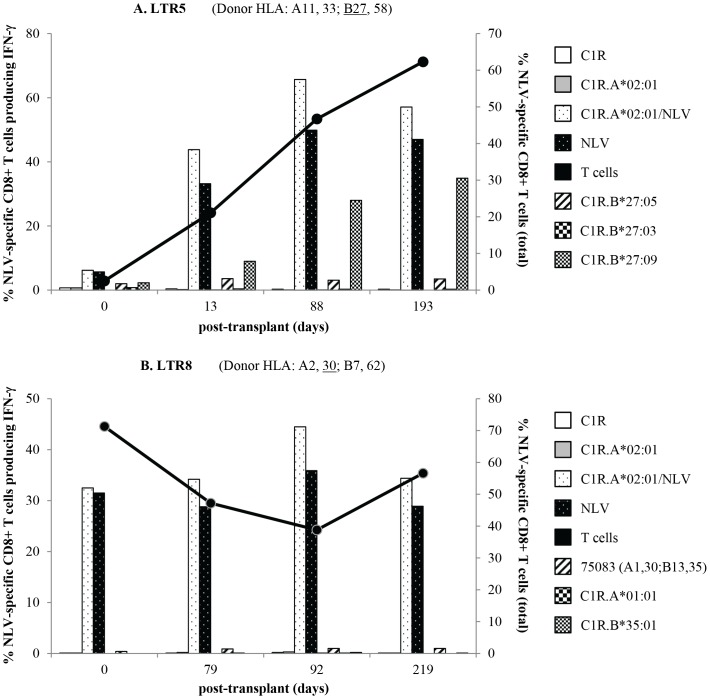
Longitudinal analysis of LTR cross-reactivity.NLV-specific cross-reactivity responses against B27 and A30 were measured against time after lung transplant in LTR5 ([A] top) and LTR8 ([B] bottom), respectively. Following a 6 hour ICS assay of day 13 T cell cultures, B*27:09 cross-reactivity significantly increased over time in LTR5, whereas A30 cross-reactivity remained stable post-transplant in LTR8. Percentages were based on IFN-γ production of NLV-specific +CD8+ T cells. The secondary axis represents the percentage of NLV-specific CD8+ T cells gated on total CD8+ T cells (circles).